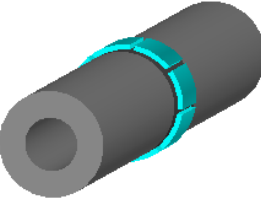
Figure 2. 3-D structure model of electrodes set in Ansoft.